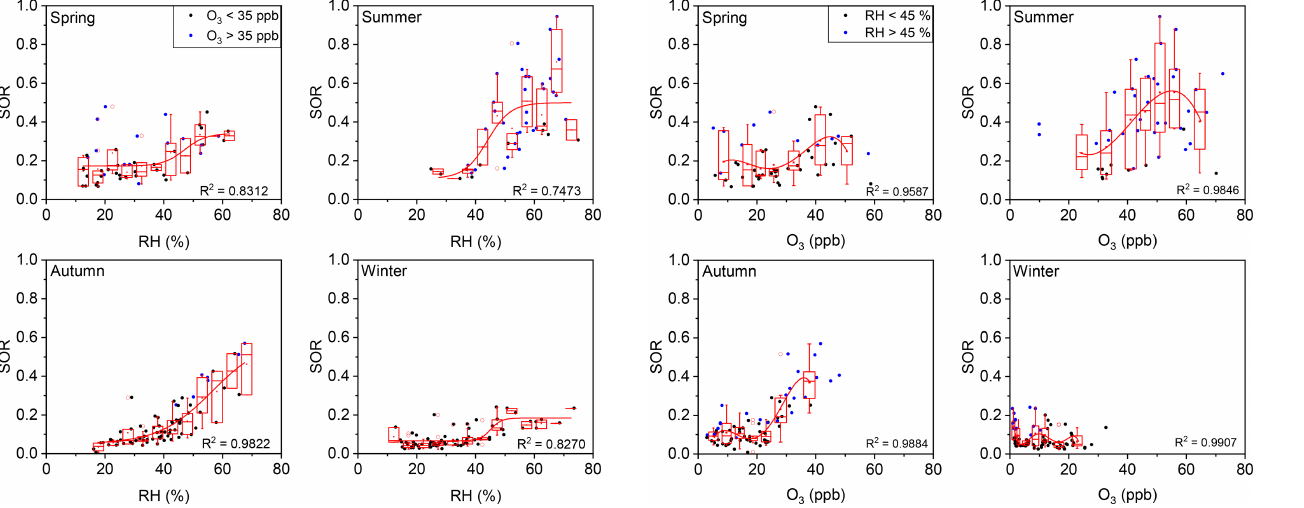
Figure 6. Plot of SOR against RH grouped by O 3 concentration in four seasons. The solid blue circles represent O 3 > 35ppb and the solid black circles represent O 3 < 35ppb. The boxes represent, from top to bottom, the 75th, 50th, and 25th percentiles in each bin ( (cid:49) RH = 5%). The whiskers, solid red squares, and open red circles represent 1.5 times the IQR, mean values, and outlier data points, respectively. The red lines are best fits to mean values based on a sigmoid function. Data for days with rain or snow were excluded from these plots.